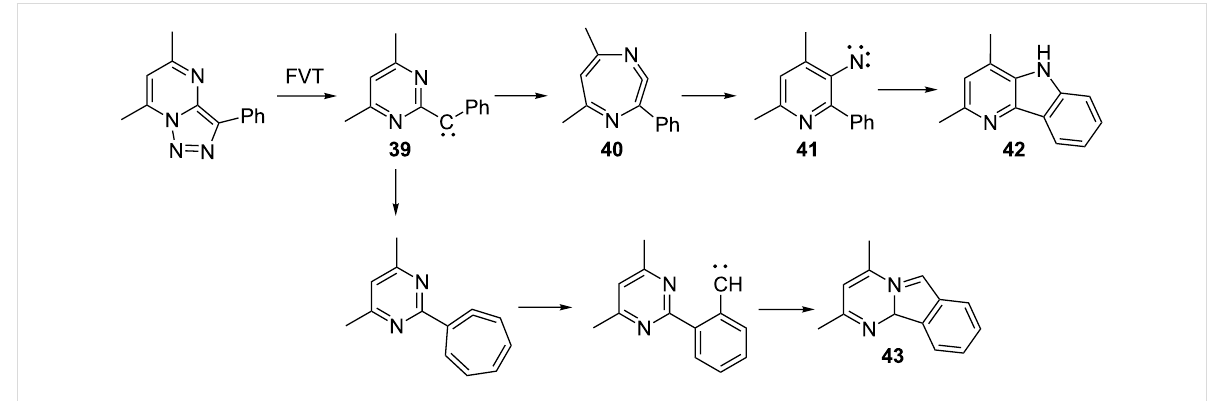
Scheme 9: Rearrangements of pyrimidinylcarbenes to cyanopyrroles via nitrile ylides 31 and 37 .